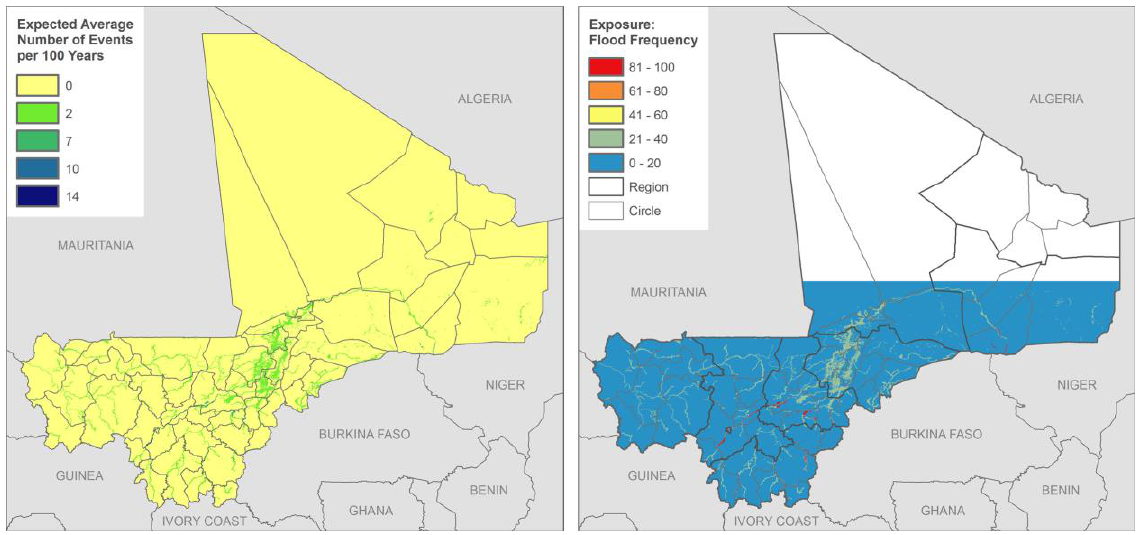
Figure 3. Flood Extent (events per 100 years)—Derived in part from MODIS flood extent data at the Dartmouth Flood Observatory, raw data ( left ) and transformed ( right